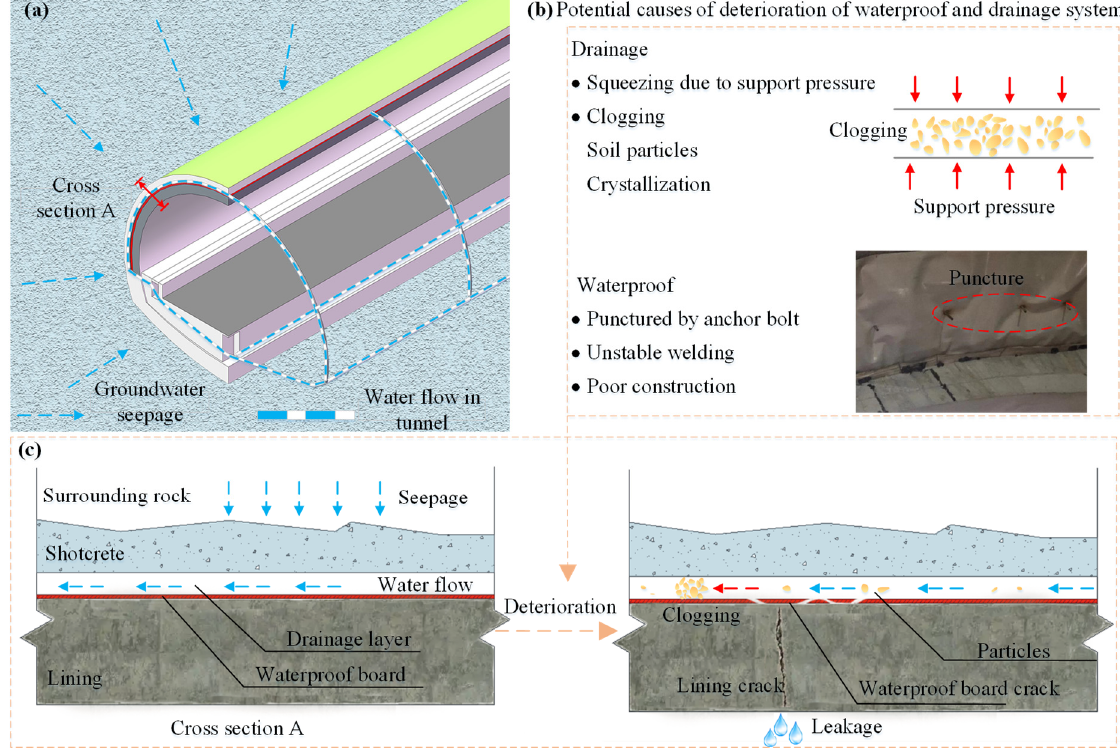
Figure 2. The diagram of tunnel deterioration. ( a ) water flow in the tunnel; ( b ) potential causes of deterioration; ( c ) leakage from the crack of section A.